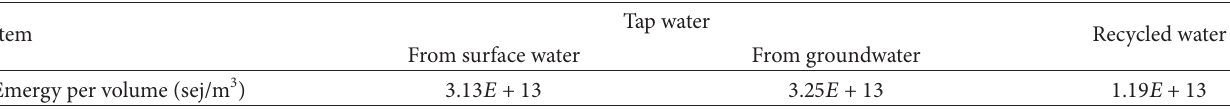
Table 3: Engineering water, tap water, and recycled water emergy per